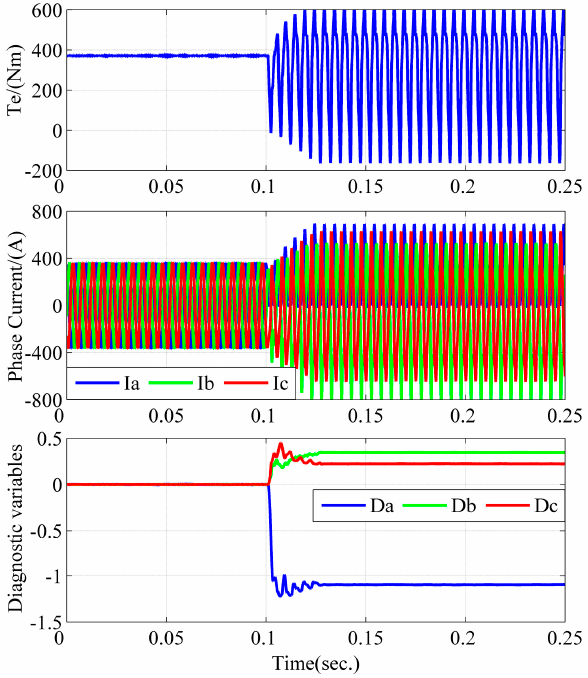
Figure 8. Diagnostic results at 2000 rpm/358 Nm.